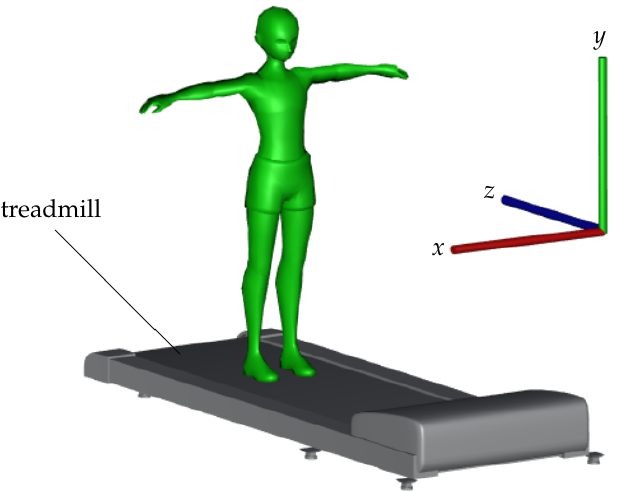
Figure 1. Our scene configuration and the corresponding 3D camera coordinate